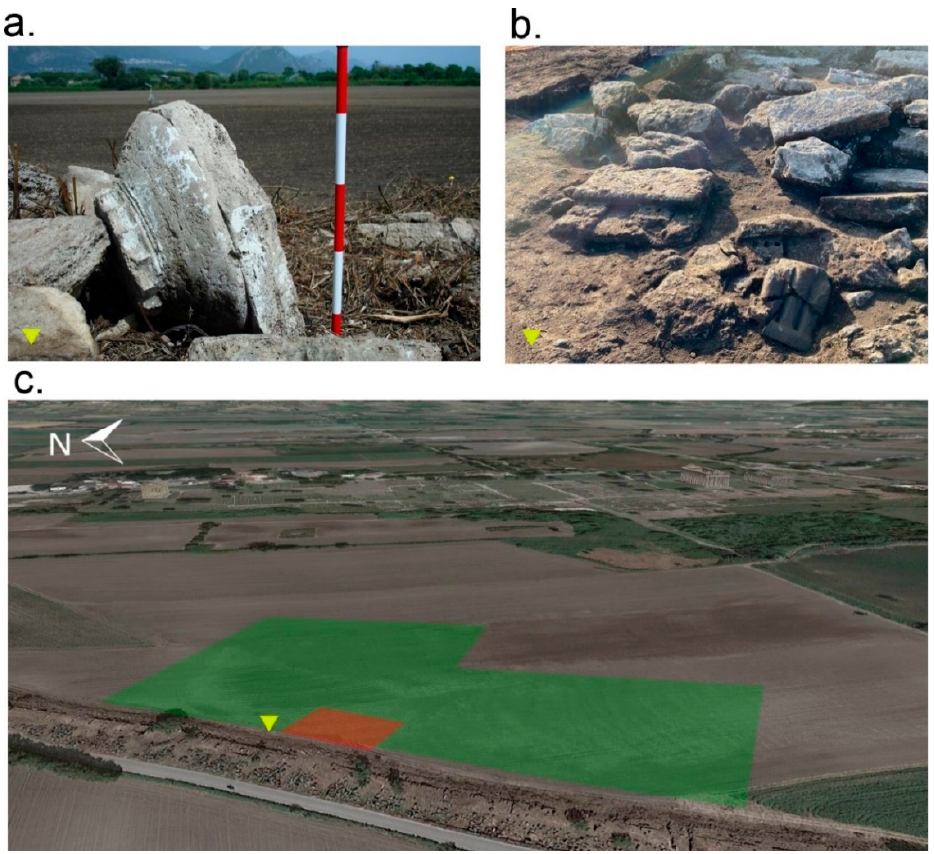
Figure 2: The archaeological findings detected during visual inspection close to the western part of the city walls in June 2019: Doric capital ( a ) and a triglyph ( b ). The green and red areas in ( c ) were investigated with MAG and GPR, respectively (the yellow triangle indicates the location of the findings shown in Figure 2a,b).